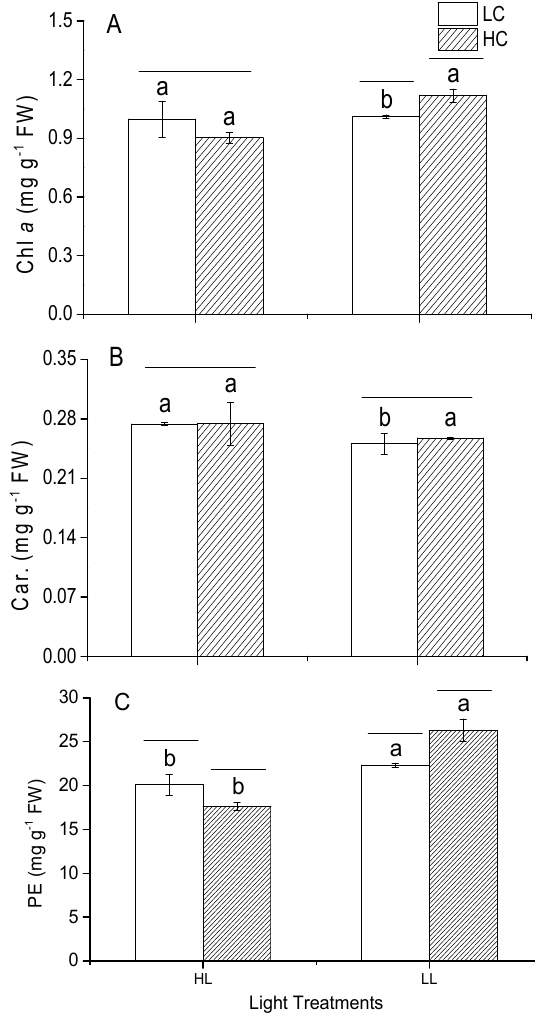
Figure 5. Chlorophyll (Chl) a ( A ), carotenoids (Car) ( B ), and phycoerythrin (PE) ( C ) content of Porphyra yezoensis under different CO 2 concentrations (400 μ atm, LC; 1000 μ atm, HC) and light treatments. Values show the mean ± SD. Different letters (a and b) represent significant differences ( p < 0.05) at different light treatments under the same CO 2 levels. Horizontal bars represent significant differences ( p < 0.05) between LC and HC under same light treatments.